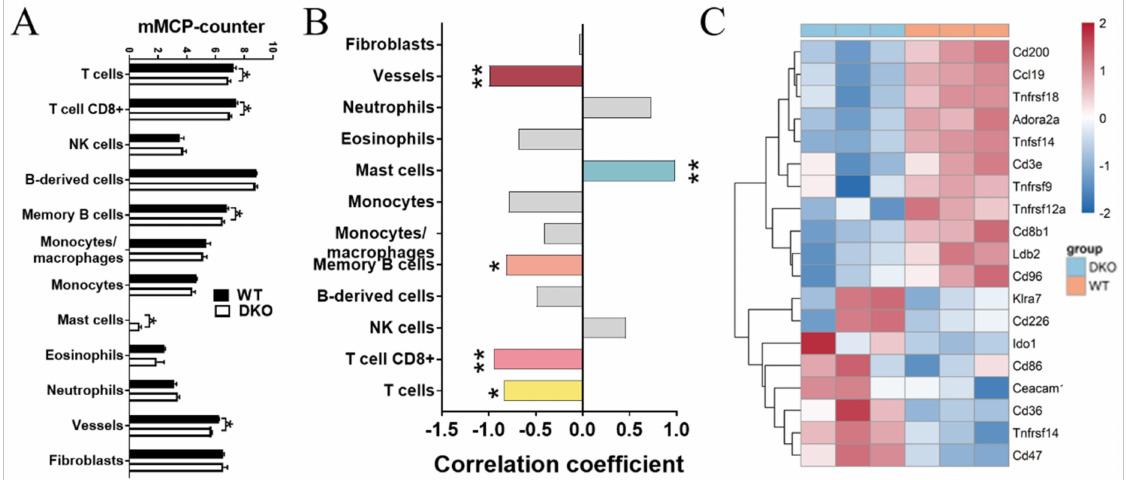
Figure 5. Differences in the immune microenvironment between the DKO and WT mice spleen. ( A ) The mMCP-counter of different immune and stromal cells in DKO and WT mice spleen. Data are presented as mean ± SD, n = 3. * p < 0.05. ( B ) The correlation between DKO score and immune cell infiltration in mice spleen. * cor_pvalue < 0.05, ** cor_pvalue < 0.01. ( C ) The differential expression of immune checkpoint genes in DKO and WT mice spleen. Blue: DKO mice; red: WT mice. mMCP- counter: murine Microenvironment Cell Population